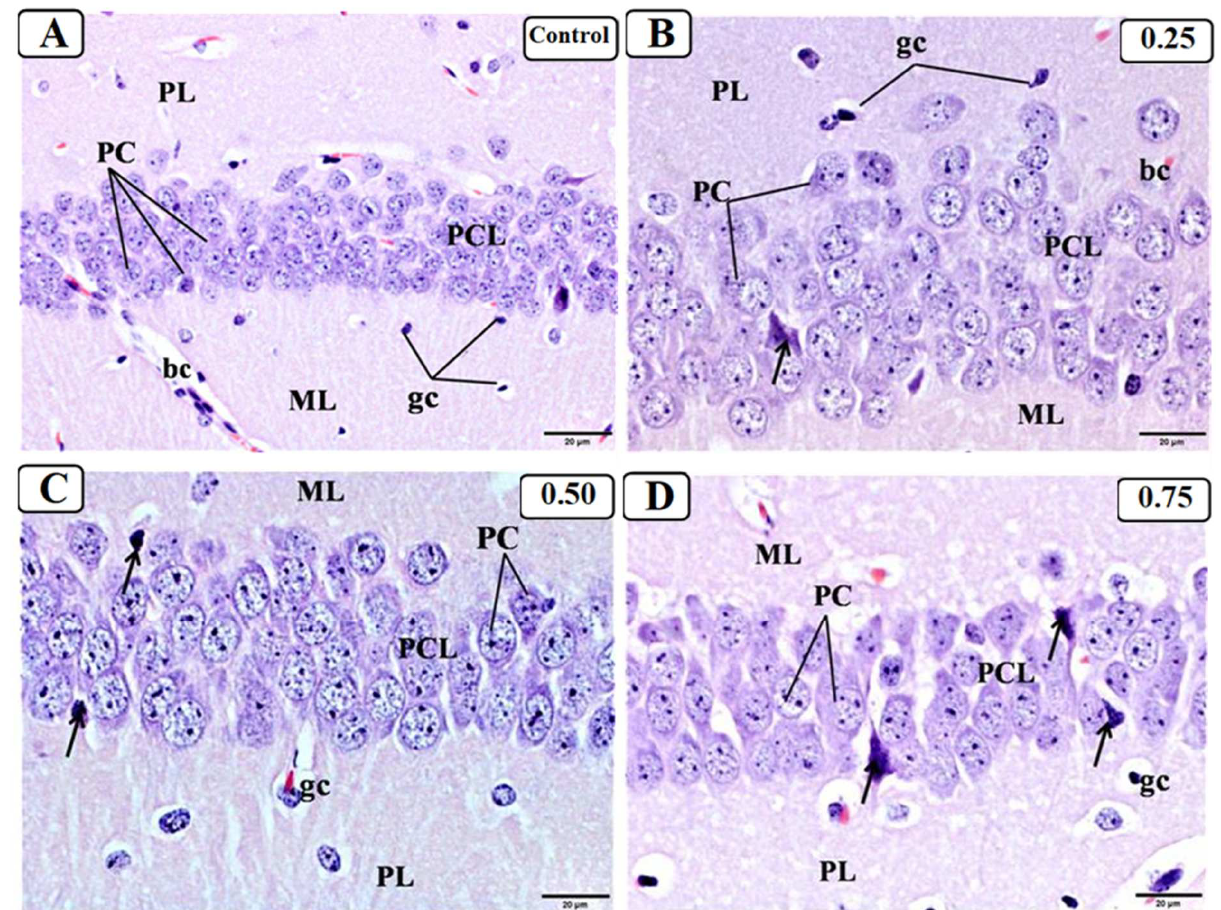
Figure 6. Representative photomicrographs of the CA1 region. ( A ) Control group contains three well-defined layers: the polymorphic layer (PL), pyramidal cell layer (PCL), and molecular layer (ML). The PCL is composed of densely packed pyramidal cells (PC) with vesicular nuclei, conspicuous nucleoli, and sparse cytoplasm. The PL and ML contain glial cells (gc) and blood capillaries (bc). ( B ) Nearly normal structure in LPS 0.25 treated group. Notice the presence of some PCs with dark basophilic cytoplasm without clear nucleus (arrow). The PL and ML displayed normal gc and bc. ( C ) Some degenerated PCs (arrow) in LPS 0.5 treated group in the PCL, which appeared condensed with pyknotic nuclei. ( D ) Many degenerated PCs (arrow) in LPS 0.75 treated group in the PCL, which appeared condensed with dark stained cytoplasm and ill-defined nuclei (H&E ×